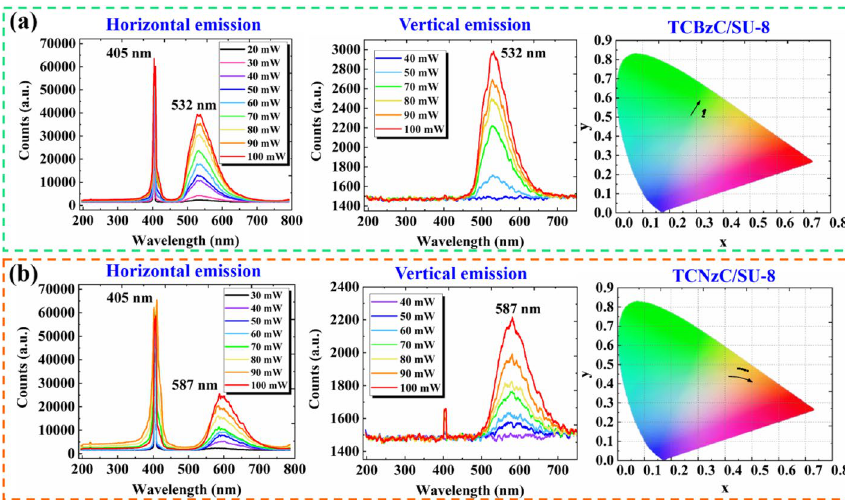
Fig. 6 a Horizontal and vertical output optical spectra for the microdisk-based 3D integrated bright sources for TCBzC/SU-8, and the corresponding CIE chromaticity diagram coordinates of the fluorescent light; b horizontal and vertical output spectra for the microdisk-based 3D integrated on-chip optical sources for TCNzC/SU-8, and the corresponding CIE chromaticity diagram coordinates of the fluorescent